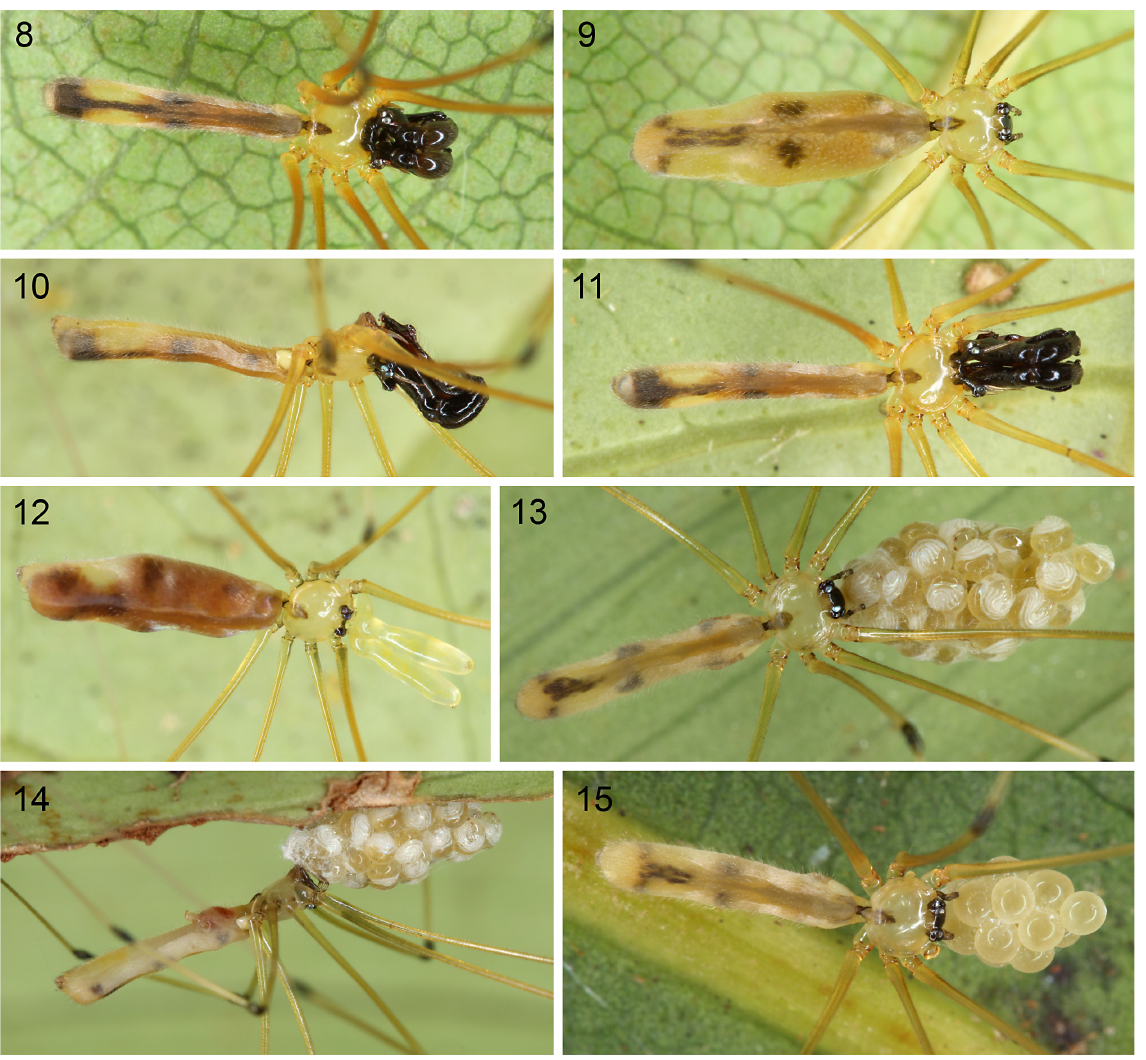
Figs 8–15. Live specimens. 8–9 . Panjange pueh Huber, sp. nov., ♂ and ♀ from Pueh. 10–14 . Pa. kapit Huber, sp. nov. from Kapit. 10–11. Adult ♂, 12. Penultimate instar ♂, 13–14. ♀ with egg-sac. 15 . Pa. niah Huber, sp. nov., ♀ with egg-sac from